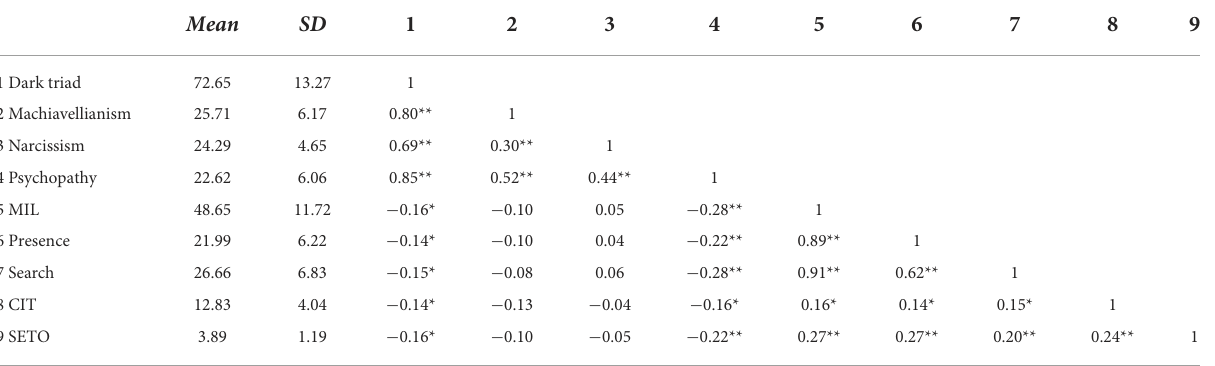
TABLE 1 Descriptive statistics and correlations of study